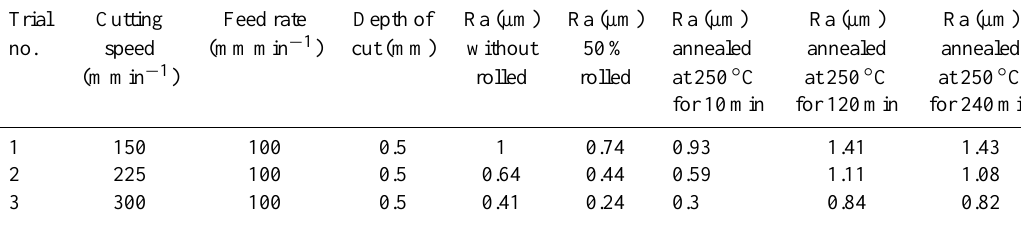
Table 5. The average roughness for the original, rolled, and crystallized samples with different speeds. Trial